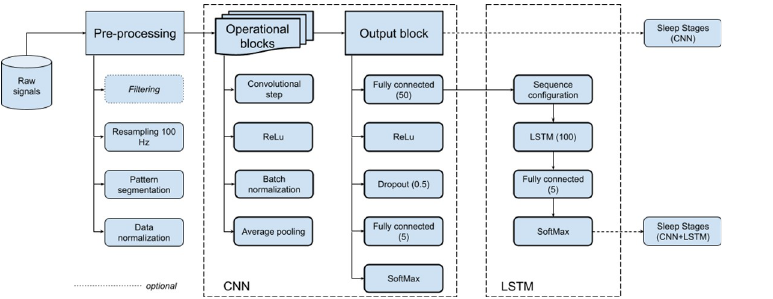
Fig 1. Preprocessing steps and general CNN-LSTM neural network